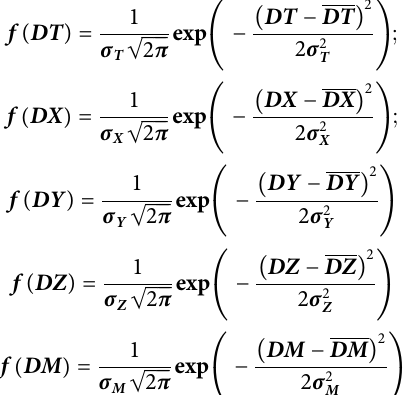
FIGURE 3 | Modi fi cation of the nearest neighbor method for identifying duplicatesinearthquakecatalogs.Blueandgraycirclesareeventsofthemain and additional catalogs, respectively, identi fi ed duplicates are shown by red arrows on the Step II panel.